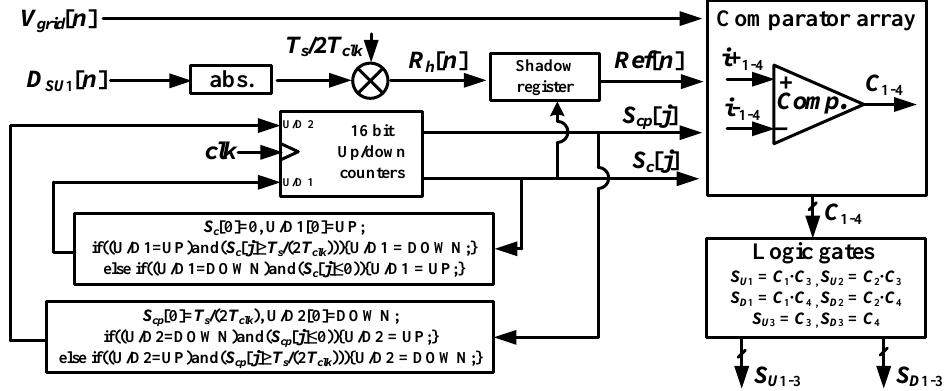
Figure 8. Block diagram of the gate pulse generator.